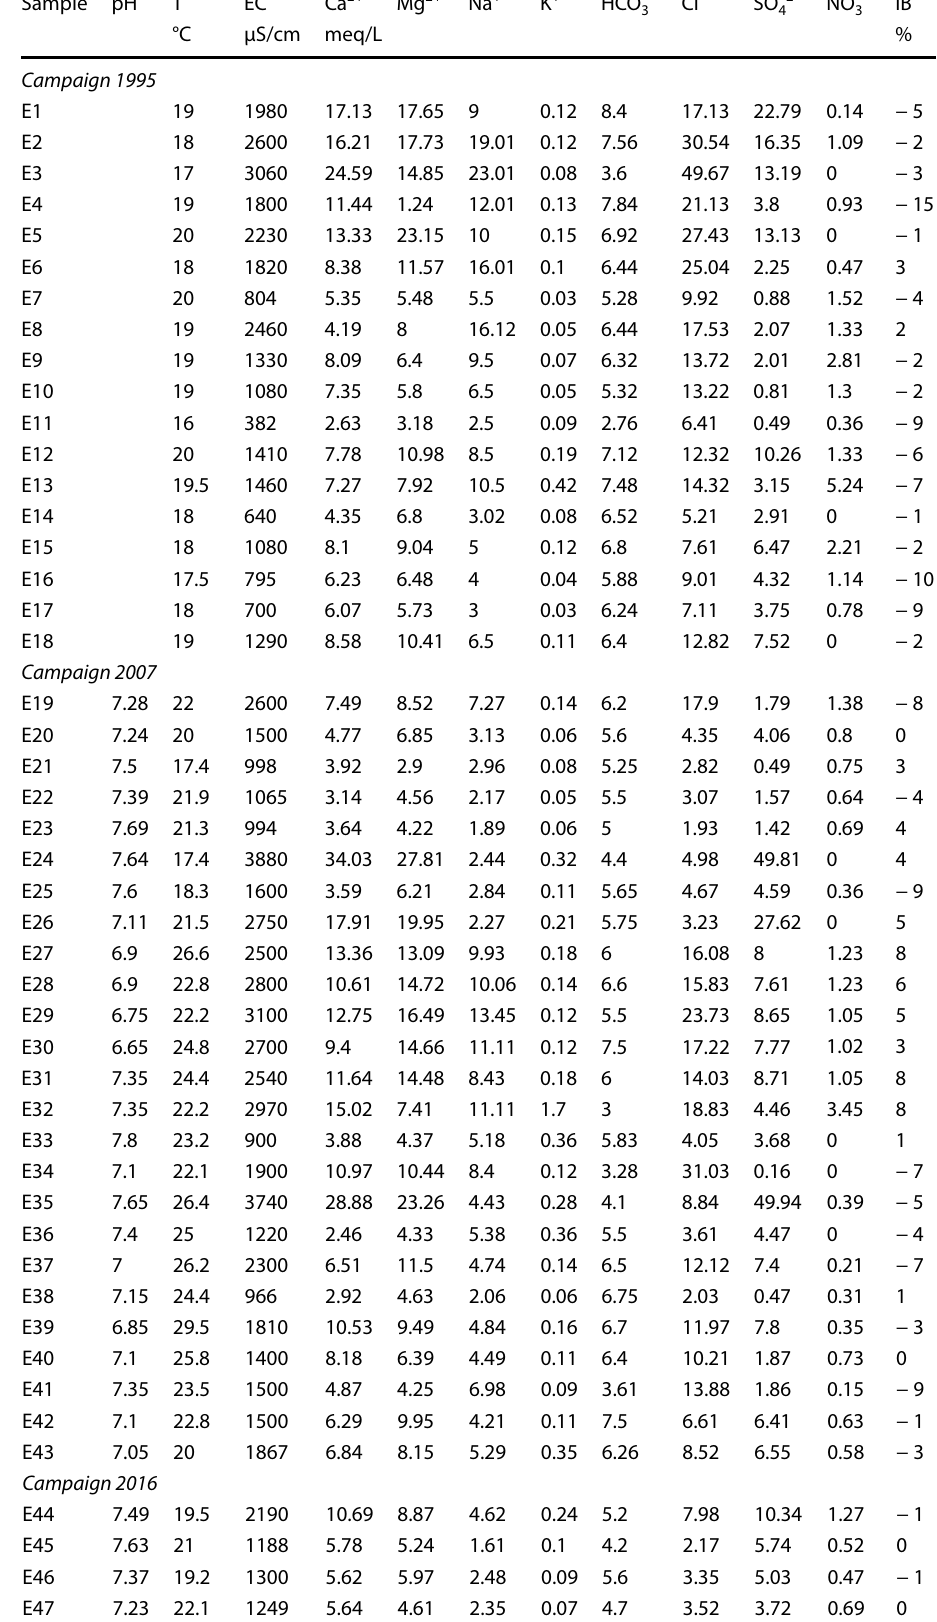
Table 1 Chemical composition of analysed samples of four campaigns 1995, 2007, 2016 and